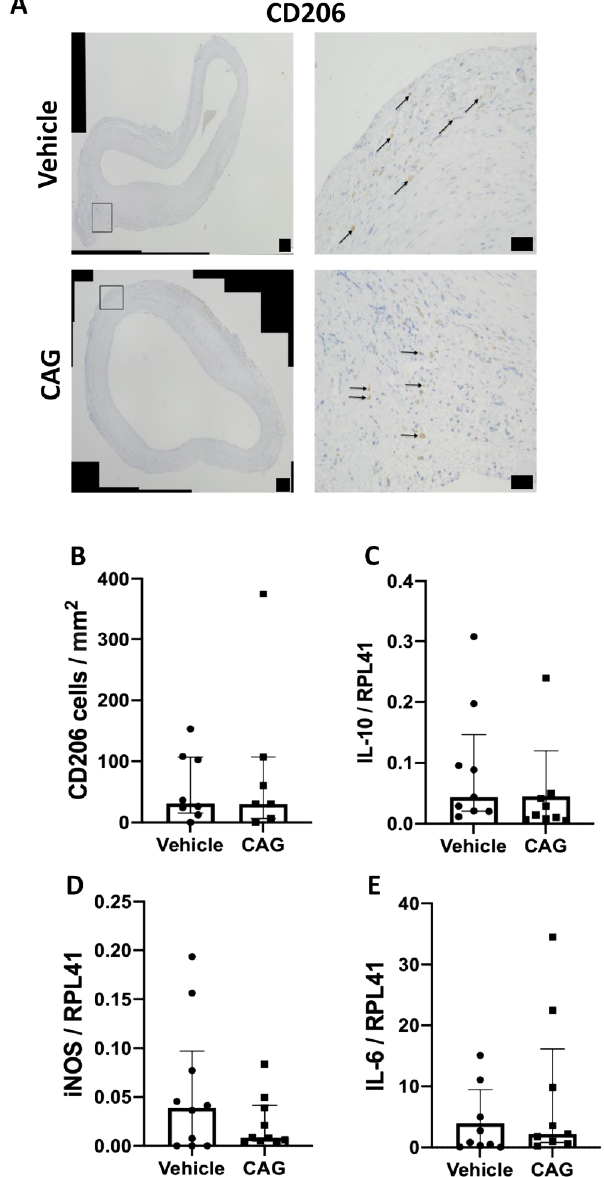
Figure 6. Markers for M1 and M2 macrophages and cytokine expression in the aneurysm wall after 28 days on vehicle or CAG treatment. ( A ) Representative micrographs of CD206 positive staining from vehicle and CAG AAAs at day 28 (enlargement represent black square on the left image). Arrows mark positive cells (n = 8/7). Scale bar (black box) in micrographs to the left: 100 µm and in micrographs to the right: 50 µm. ( B ) Semi-quantification of CD206 positive cells in each group per mm 2 in adventitia. ( C ) Relative mRNA levels of IL-10 (n = 10/10), ( D ) inducible NO synthase (iNOS) (n = 10/10), and ( E ) IL-6 (n = 9/9) in the aneurysm tissue. All RNA data is normalized to RPL41 mRNA levels. All values are median ± interquartile